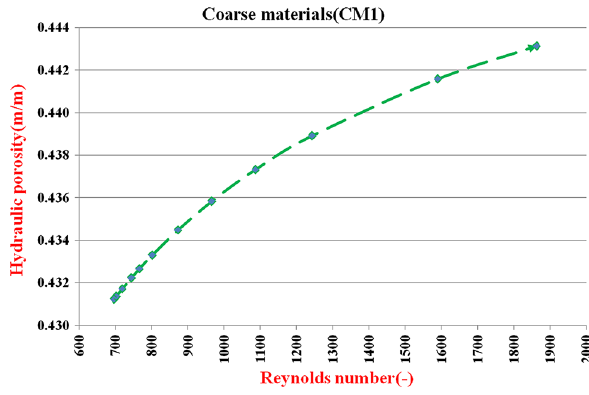
Fig. 5 Variation of hydraulic porosity versus Reynolds number for CGM1 with d m = 14.20 mm